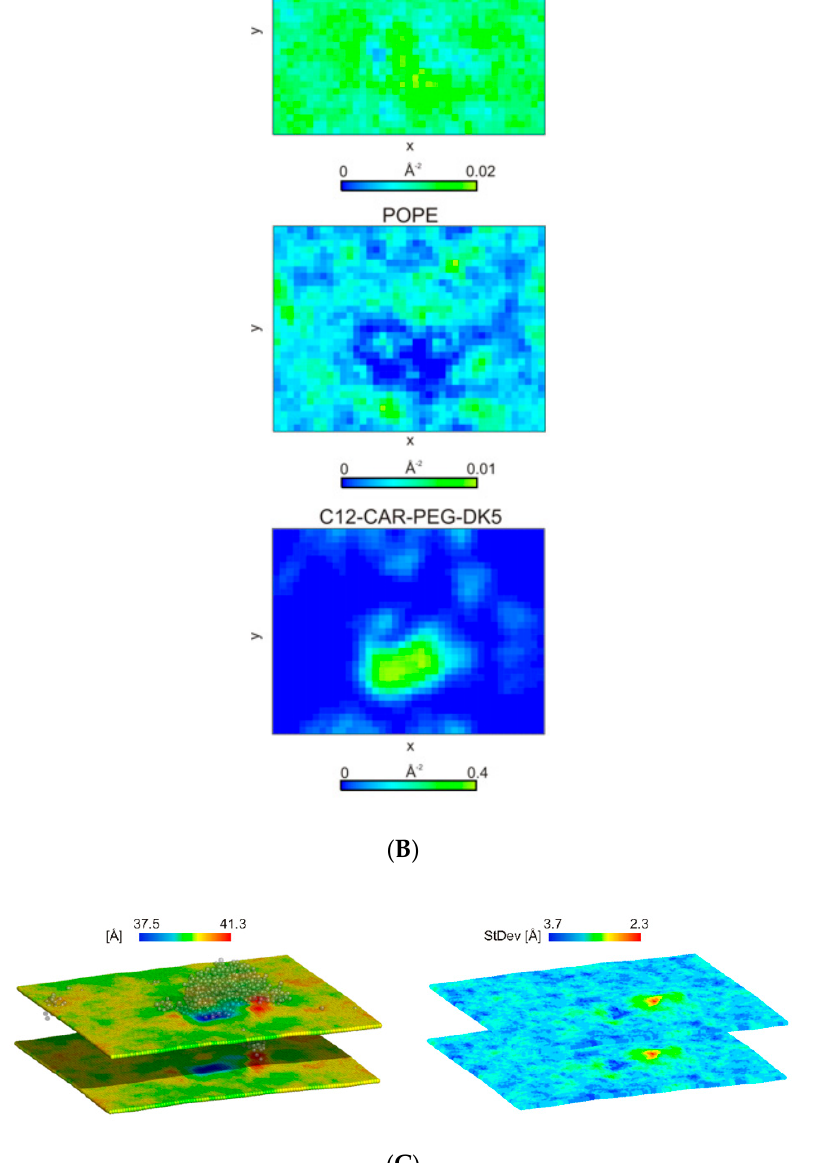
Figure 9. ( A ) Snapshots from the 1:3 POPE:POPG binding simulations for C12-CAR-PEG-DK5. Backbone and side chain beads are colored red and yellow, respectively. Lipid tails are colored gray, while lipid head groups are colored ice-blue and pink for POPG and POPE, respectively. ( B ) 2D density map of C12-CAR-PEG-DK5, POPG and POPE lipids in the upper leaflet of the membrane. A grid spacing was set to 5 Å. Last 100 ns of a total of 2 µs CG MD simulations were considered for analysis. ( C ) The time-averaged local thickness of the 1:3 POPE:POPG bilayer showing a perturbation of the membrane upon C12-CAR-PEG-DK5 binding. The data were averaged over last 100 ns of MD simulations. Phosphate beads of the lipid headgroups were considered for calculations.